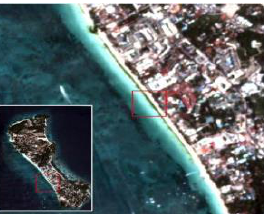
Figure 6: Whole extent of Boracay Island on April 25, 2018 in RGB display.